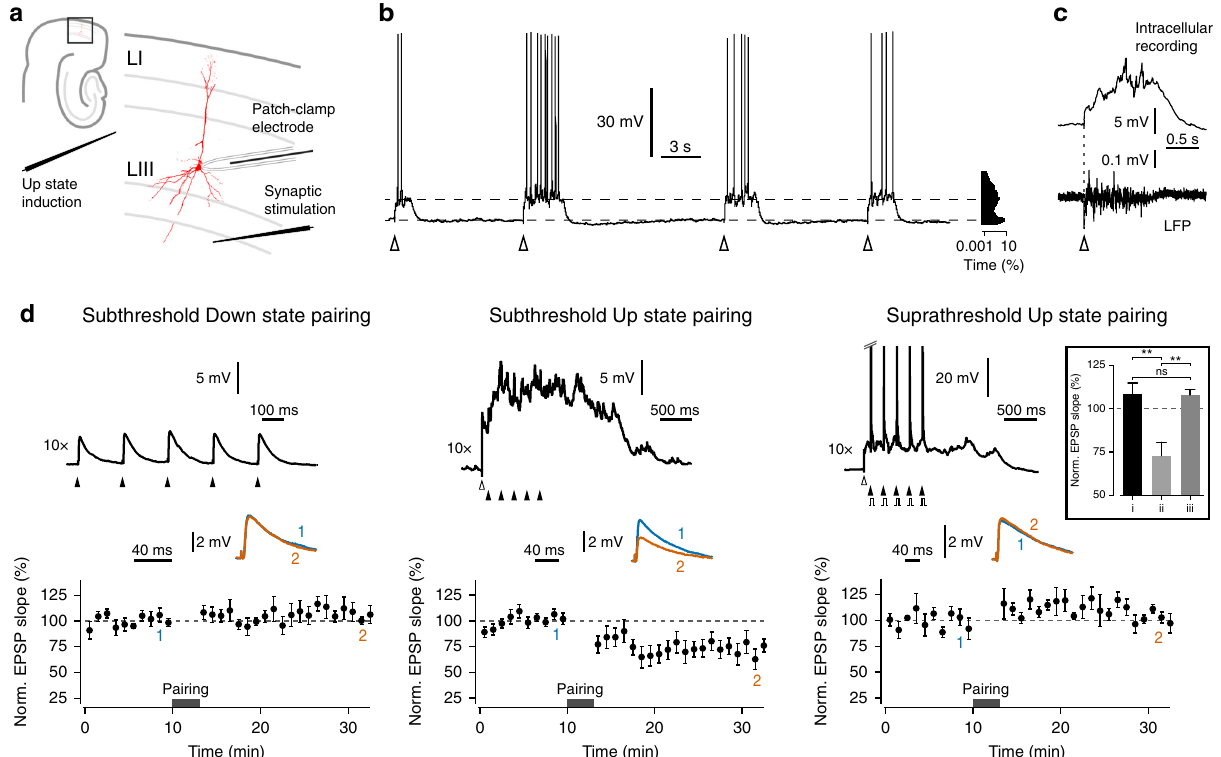
Fig. 1 Pairing subthreshold inputs with Up states causes synaptic weakening. a Schematic of the experimental set-up, with whole-cell patch-clamp recordings obtained from a LIII principal neuron, and extracellular stimulation electrodes placed in LIII and the border of the deep layers, to evoke local Up states and single EPSPs, respectively. b Current-clamp recording from a layer III principal cell shows reliable induction of Up states following electrical stimulation in LIII ( white arrowheads ), resulting in a typical bimodal distribution of the membrane potential ( right histogram ; percentage of time on a logarithmic scale). c Simultaneous whole-cell current-clamp ( upper trace ) and LFP ( lower trace ) recordings from layer III showing an induced Up state. d Single EPSPs were evoked every 15 s during Down state periods in order to measure synaptic strength during baseline, and following three pairing protocols with 5 Hz stimulus trains: Down state pairing (total of 50 individual EPSP pairings; n = 6; left panel ), Up state pairing (total of 50 individual EPSP pairings; n = 9; middle panel ), and Up state pre-post spike pairing (total of 50 – 100 individual EPSP pairings; n = 6; right panel ). Top : example recordings during pairing protocols, showing the timings of the synaptic stimuli ( black arrowheads ), Up state induction ( white arrowheads ), and the brief somatic current injections used to evoke spiking following each synaptic stimulation in the Up state pre-post pairing protocol ( grey steps ). Spontaneous spikes did occur during Up states, and the example traces with no background spiking are chosen to emphasize that responses to synaptic stimulation were predominantly subthreshold during pairing, which is further detailed in Supplementary Fig. 1. Middle : representative EPSP traces from the baseline period (1; blue ) and the end of recording (2; orange ) (mean of fi ve traces). Bottom : pooled data of normalized single EPSP slope across experiments for each pairing protocol (1 min bins). Inset : summary statistics, showing that only the subthreshold Up state pairing induced synaptic weakening. ** P < 0.01, One-Way ANOVA followed by Tukey ’ s multiple comparisons test. Error bars show the